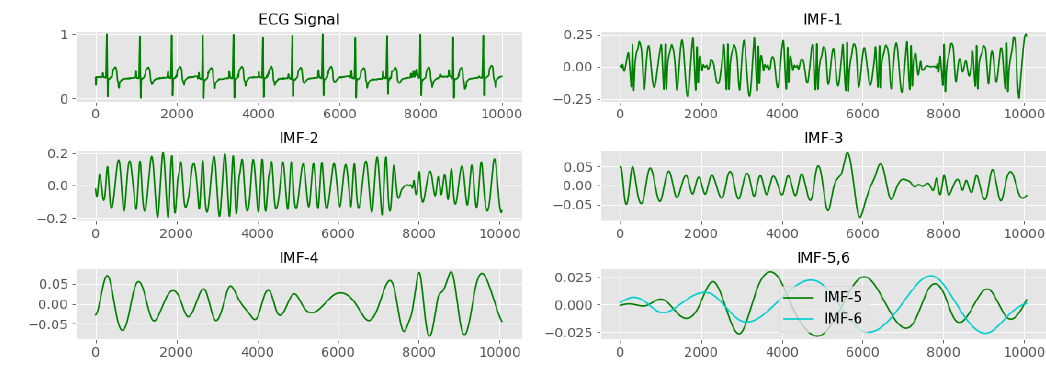
Figure 8. The first six IMFs and the base ECG wave.